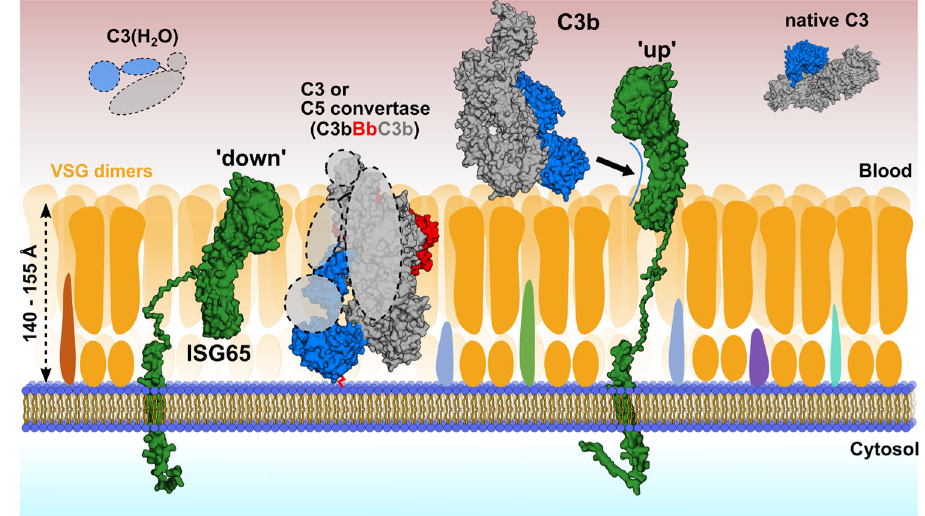
Fig. 9 | Model of complement binding on the surface of T. b. gambiense . In its compact ‘ down ’ position,ISG65wouldremainembeddedwithintheVSGcoat,with its C3-binding epitopes being concealed and only the disordered head domain exposed totheoutside.Inthisstate,ISG65maybindandinactivateAPconvertases via C3b that may pass through the VSG coat, where it could covalently bind to the plasma membrane via Gln1013 of the former thioester (red connecting line). In its extended ‘ up ’ position, ISG65 would be to ableinterceptC3boutsidethe VSG coat and transport it to the fl agellar pocket for uptake and subsequent